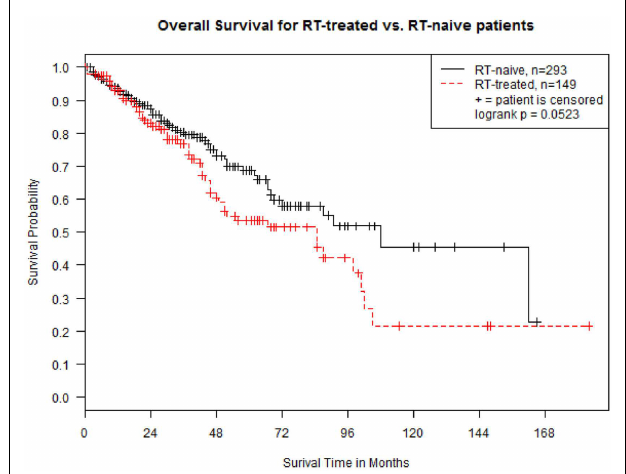
FIGURE 1 | Kaplan–Meier estimates of overall survival in 442 patients with multiple myeloma, divided in “RT-naive” (GroupA, n = 293 -solid line) and “RT-treated” (Group B, n = 149 -dotted line) . Survival is calculated from the time of diagnosis.